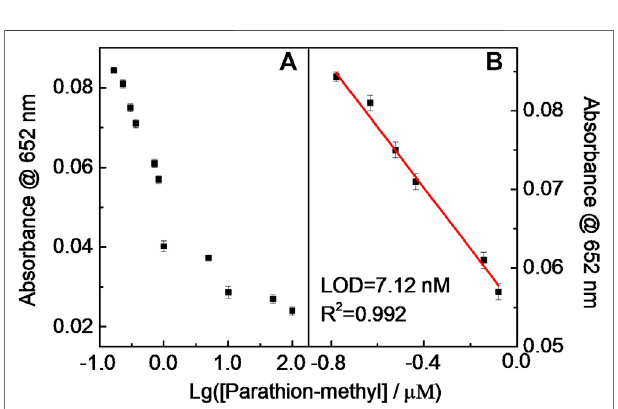
FIGURE 13 | Relationship curve (A) and the linear fi tting (B) between Abs at 652 nm and Lg (parathion-methyl).